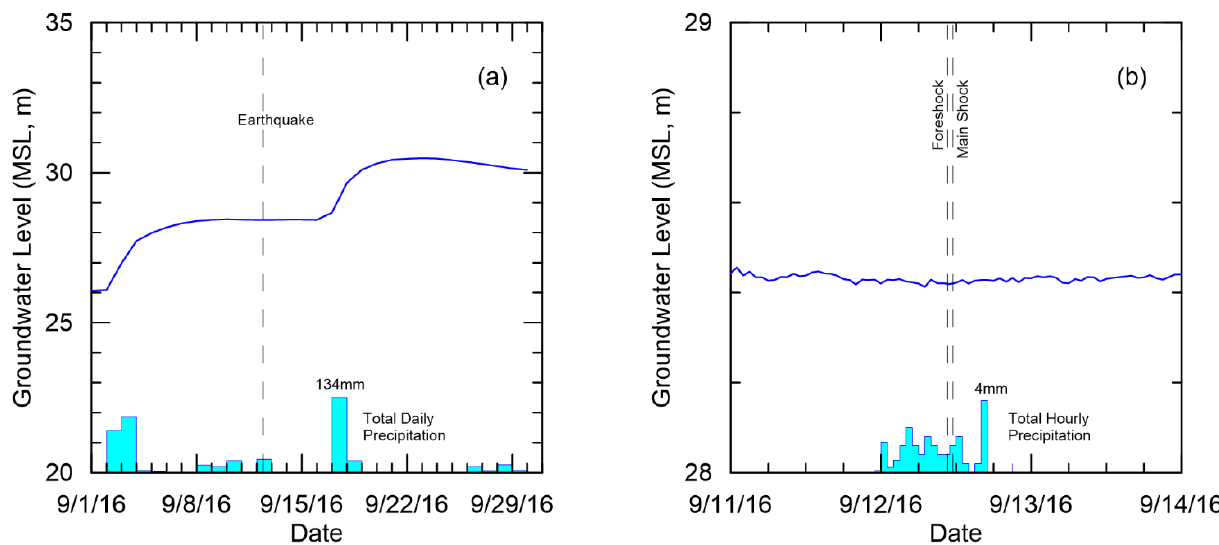
Figure 6. Groundwater level changes for well W1 during ( a ) September 2016 and ( b ) a closer inspection of the 3 days around the earthquake event.